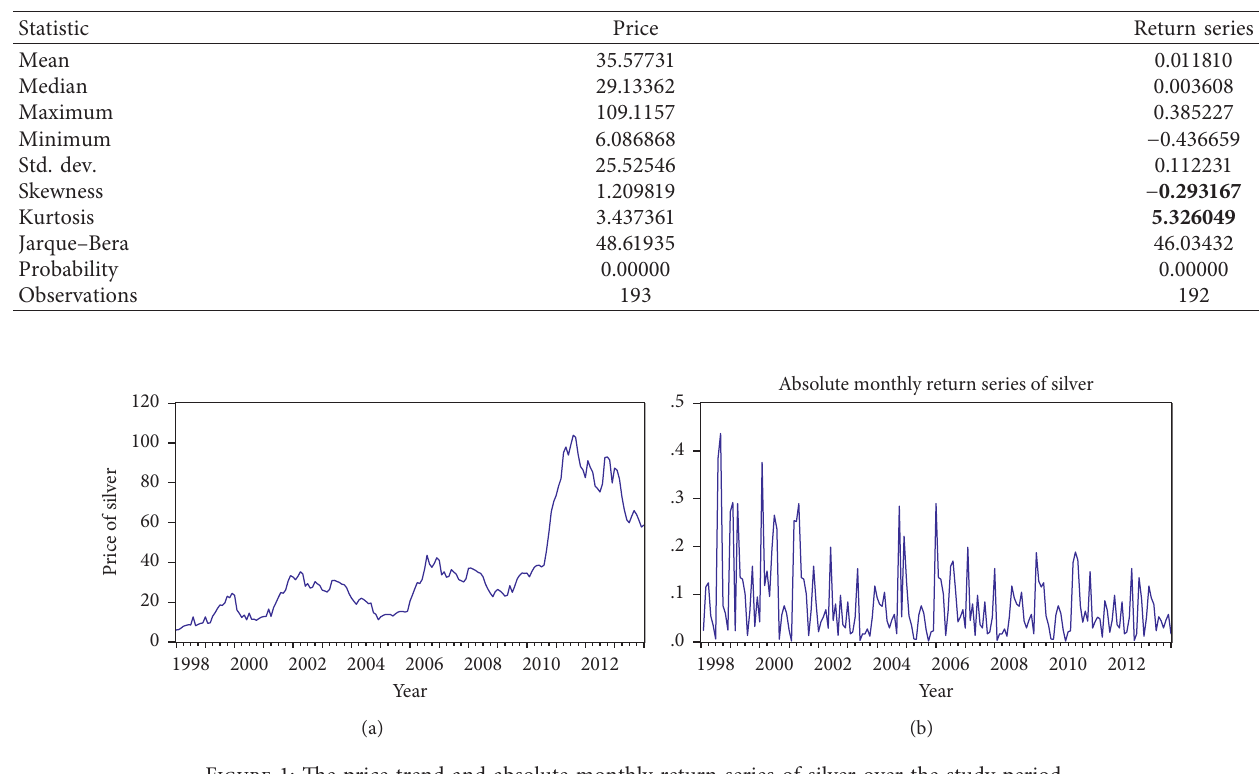
Table 1: Summary statistics for monthly prices of silver (price per gram in birr) and their return